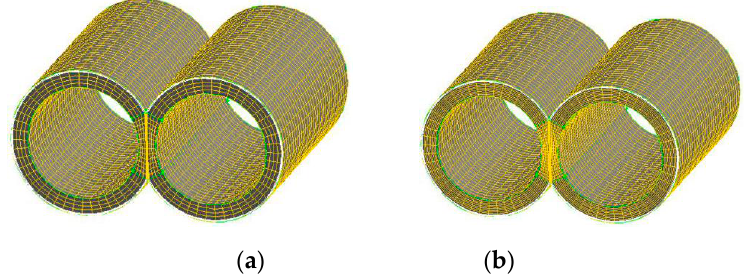
Figure 3. Finite element models with different mesh densities: ( a ) mesh A; ( b ) mesh B.